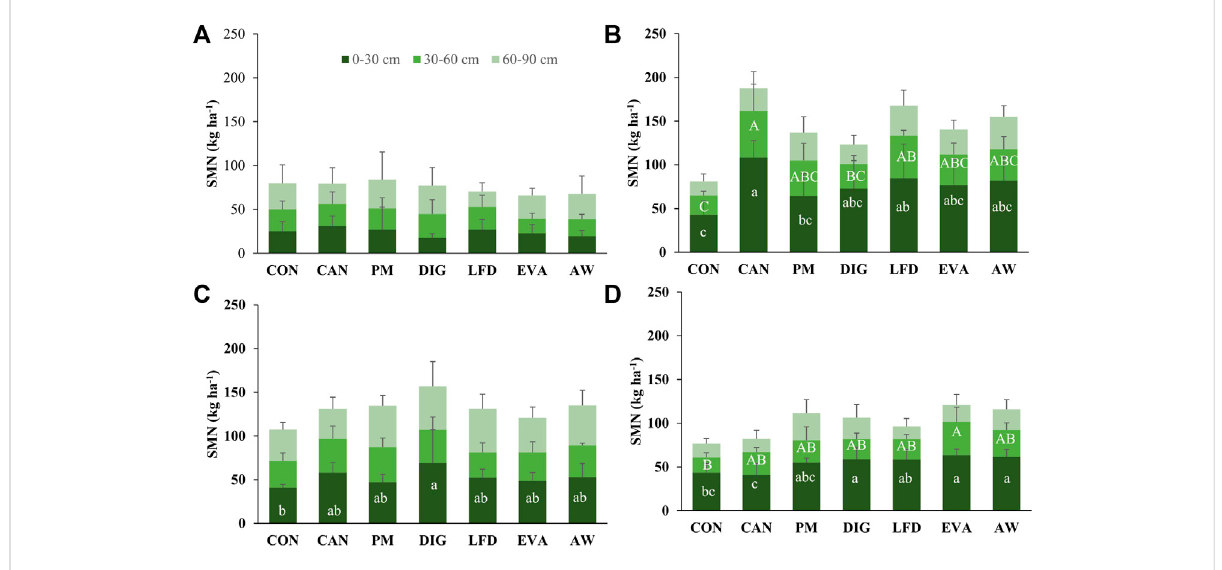
FIGURE 5 Soil mineral N (SMN, mean ± standard deviation, kg ha − 1 , n = 4) at different soil depths (0 – 30, 30 – 60, 60 – 90 cm) observed at sampling moments (A) T1 (8 May 2020), (B) T2 (9 July 2020), (C) T3 (18 August 2020) and (D) T4 (22 September 2020). The lowercase and uppercase letters refer to the statistical difference of SMN between treatments at 0 – 30 and 30 – 60 cm depth, respectively, using one-way ANOVA and Fisher ’ s Least Signi fi cantDifference (LSD)post-hocpairwisecomparisonsata5%level.nosigni fi cantdifferencewasobserved at60 – 90 cmdepth.CON,no- N control; CAN, calcium ammonium nitrate; PM, pig manure; DIG, digestate; LFD, liquid fraction of digestate; EVA, evaporator concentrate; AW, ammonia water.